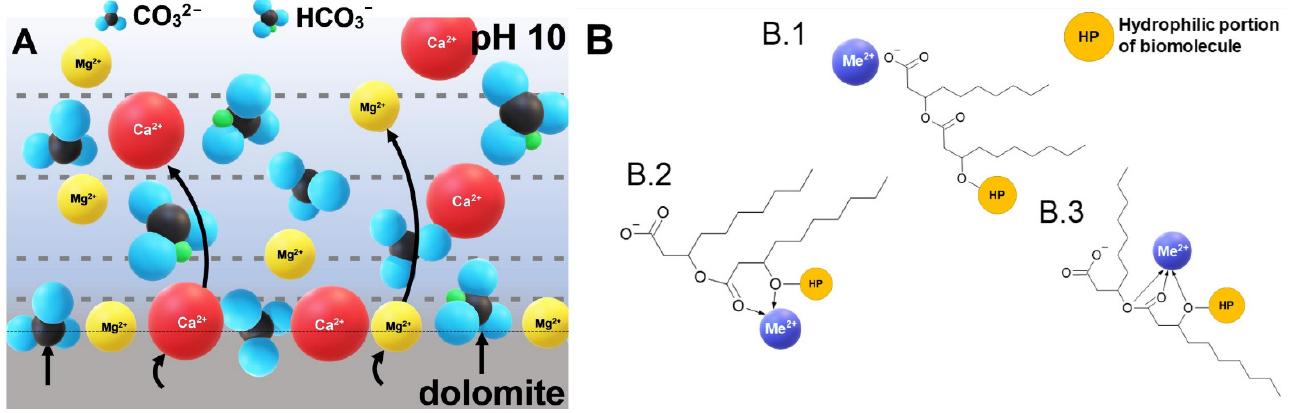
Figure 4. ( A ) The state of the surface and ionic forms of dolomite released to water at pH 10; ( B.1 – B.3 ) examples of [Me 2+ ]-rhamnolipid complexes based on [52] at pH 10.